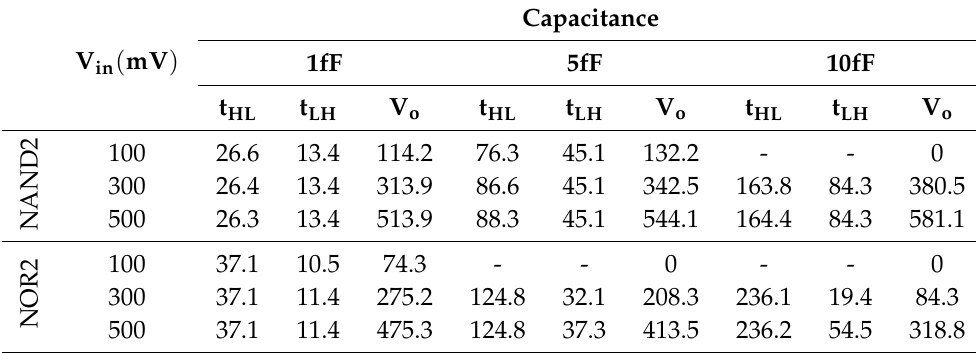
Table 1. Propagation delays and output pulse widths for the 0 → 1 → 0 transition.